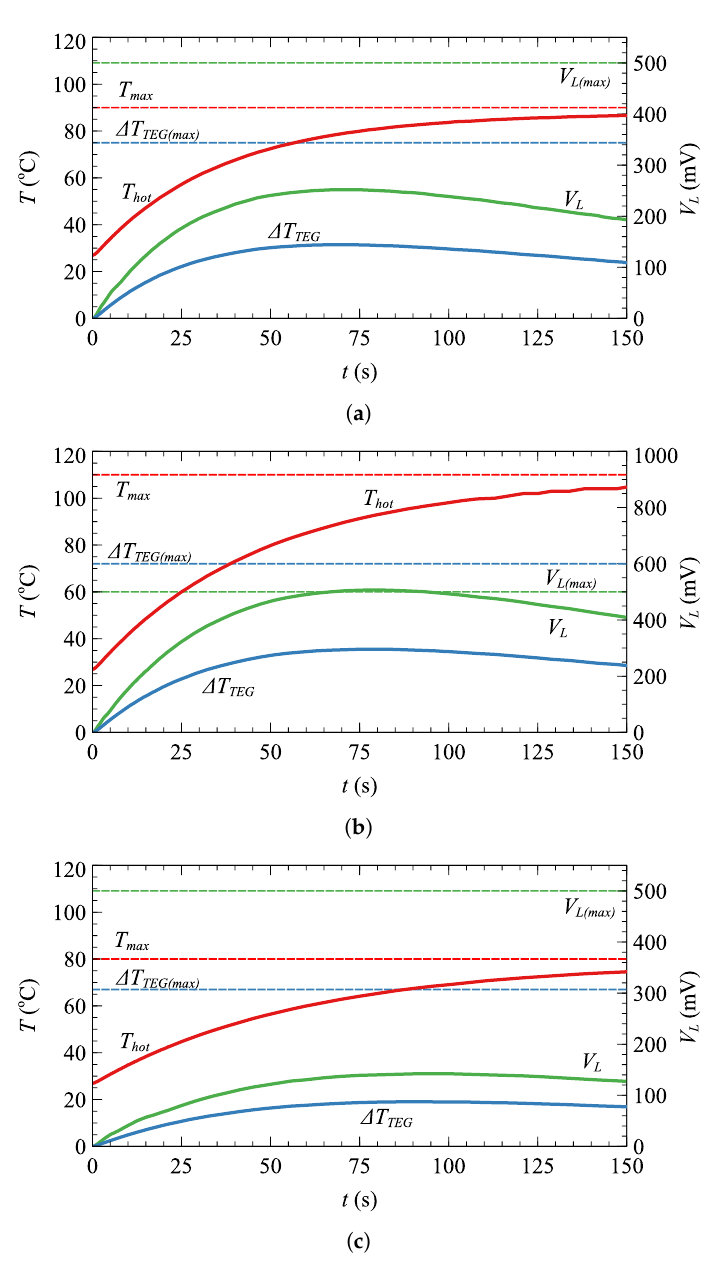
Figure 12. Simulated time dependencies of the hot side temperature ( T hot ) , effective temperature difference at the TEG ( ∆ T TEG ) and load voltage ( V L ) for T HEAT = T max and the node with: ( a ) TEG1; ( b ) TEG2; ( c ) TEG3. T AMB = 27 ◦